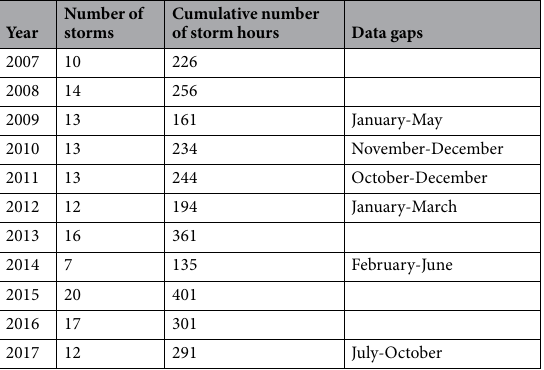
Table 1. Storms identification during the last ten years using data from the Cesenatico buoy station. Storm identification is based on the criteria of 15 and corresponds to a storm threshold of wave height > 1.5 m; individual storms are identified by a 3 hours interval with the wave height below threshold; minimum storm duration considered is 6